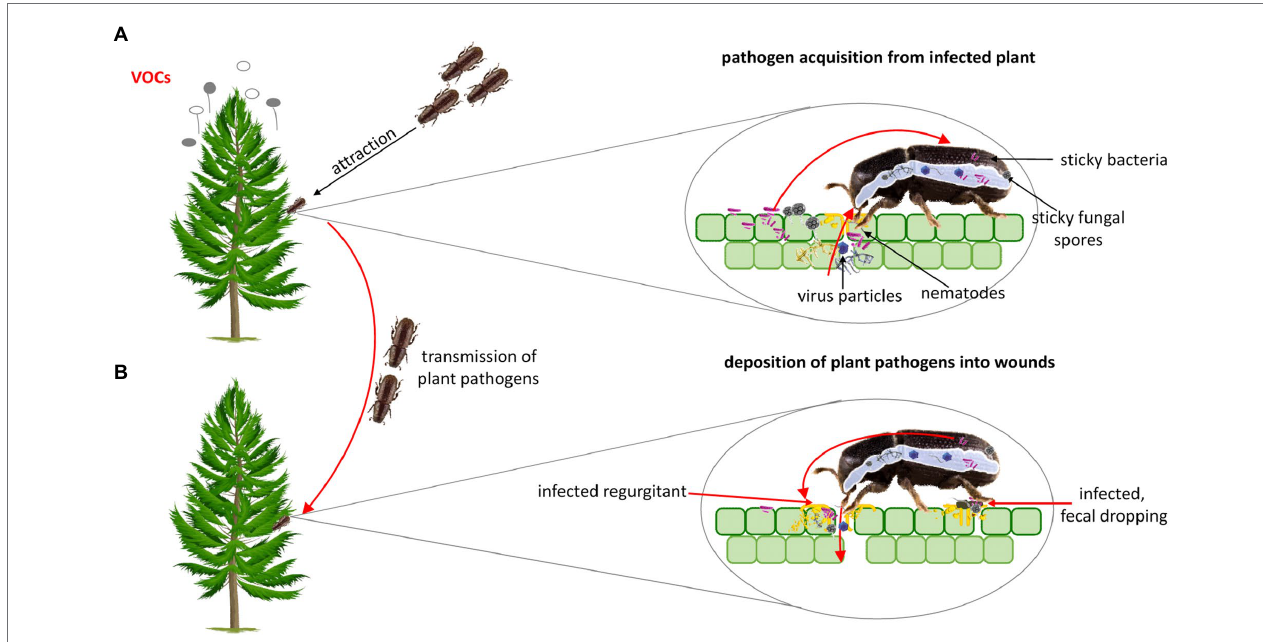
FIGURE 2 | (A) Plant pathogens can enhance their acquisition and transmission through altering plant volatile organic compounds (VOCs) that attract insect vector to infected plants. In some cases both the larval and imago stage may be involved in the transmission of plant pathogens. Beetles can acquire plant pathogens incidentally (the bacterial and fungal spores are often sticky and cling to the insect’s body) and with food. (B) Ingested pathogen circulates through/within the insect body, reaches the salivary glands, mouthparts, and finally enters plant host through the wounds resulting from insect feeding. Some pathogens can be deposited into wounded place through faecal